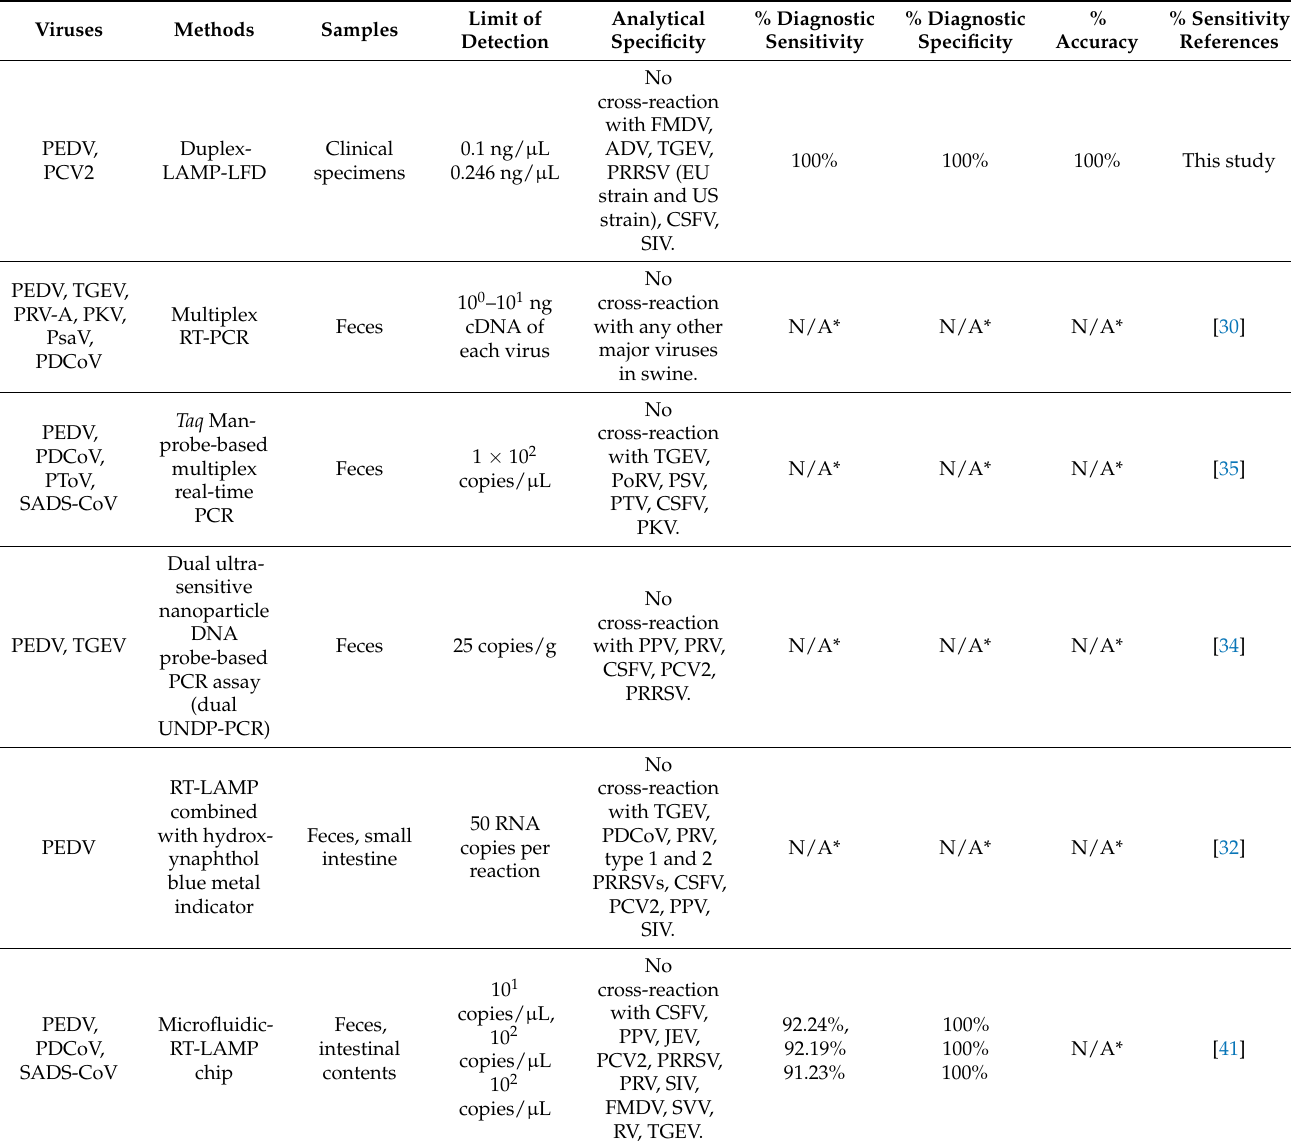
Table 4. Comparison of molecular methods for detection of PEDV and/or